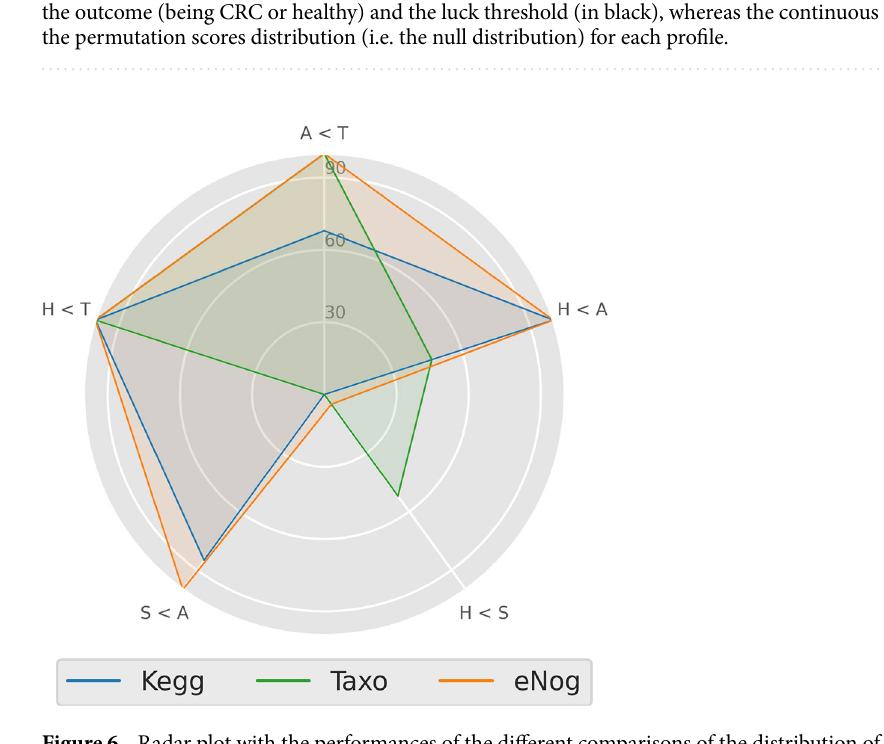
Figure 6. Radar plot with the performances of the different comparisons of the distribution of the probabilities between pairs of categories of samples using a Mann–Whitney rank test. Comparisons are clockwise: Adenoma < Tumor (A < T), healthy < Adenoma (H < A), healthy < small adenoma (H < S), Small adenoma < Adenoma (S < A) and healthy < tumor (H < T). Models were trained with Taxonomic (Taxo) and functional features (KEGG and